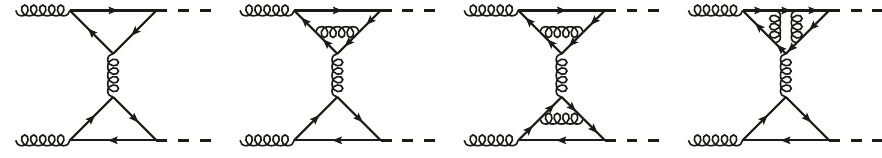
in eq. 1PR ;(cid:21) =0